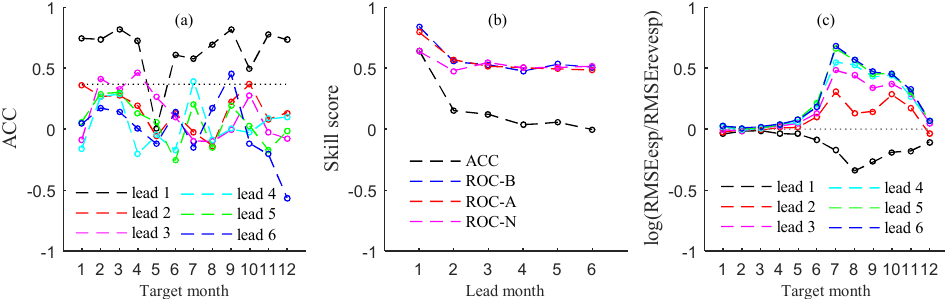
Figure 7. Variation of ( a ) ACC and ( c ) ratio of forecast to the observation variance with the target month for six lead times, and ( b ) skill scores variation with the lead time in terms of ACC and ROC areas for the Xijiang River.